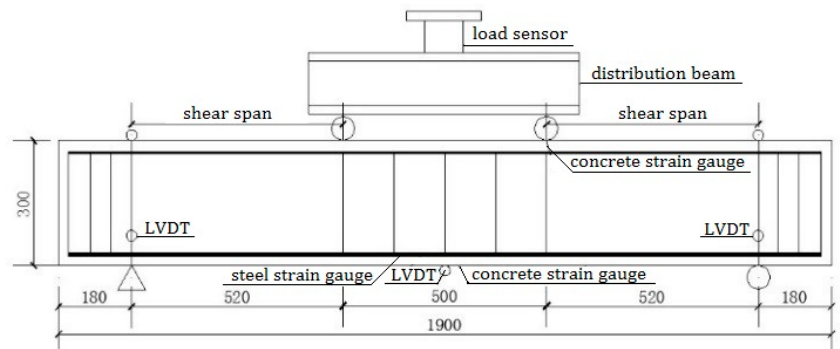
Figure 4. Test setup.